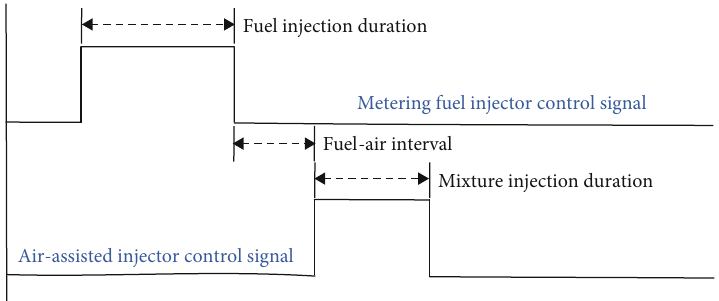
Figure 3: Control signal sequence.